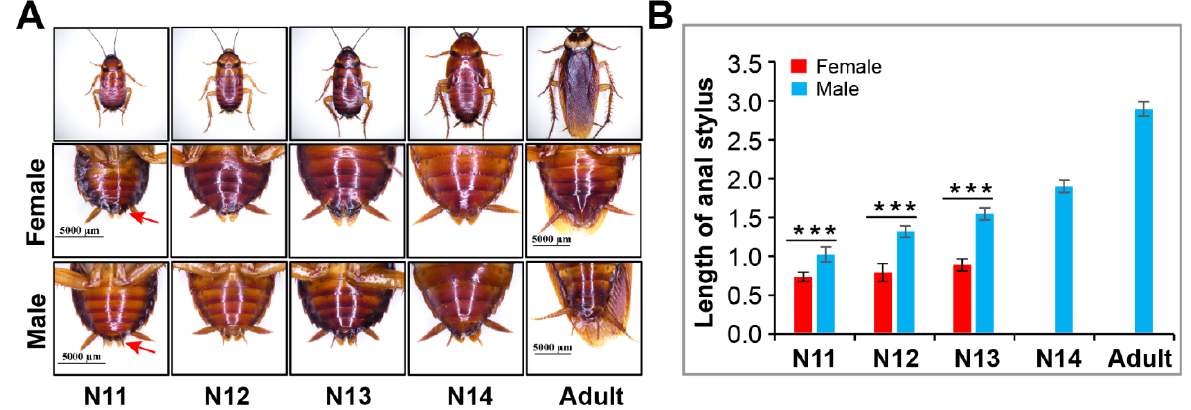
Figure 6. Identification of female and male of P. americana. ( A ) Images of female and male. Red arrows show anal stylus. ( B ) Changes in stylus length in females and males. *** p < 0.001. Scale bars: 5000 μ m.